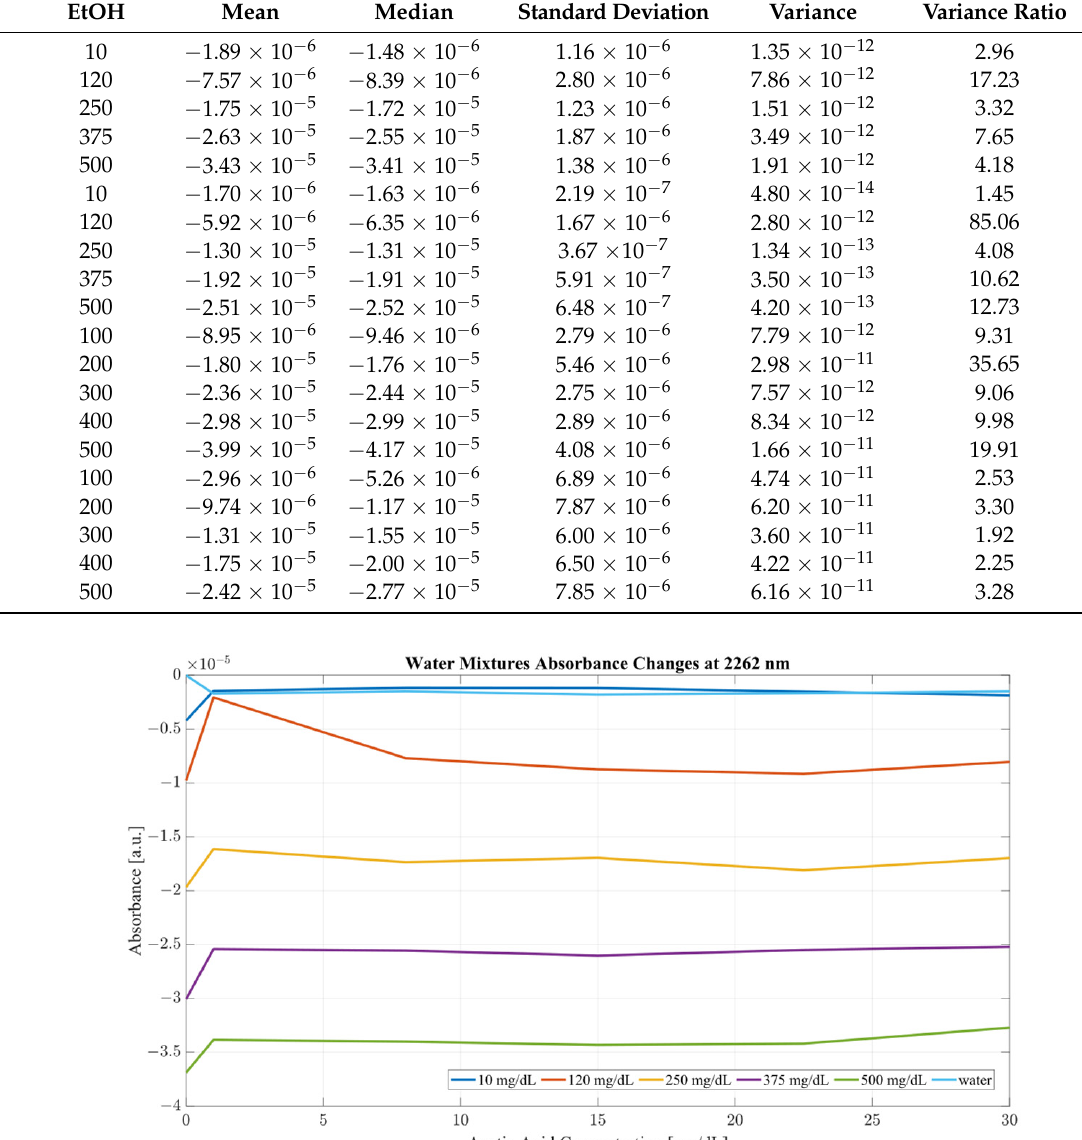
Figure 7. Water mixture absorbance changes at 2302 nm. Figure 8. Serum mixture absorbance changes at 2262 nm.